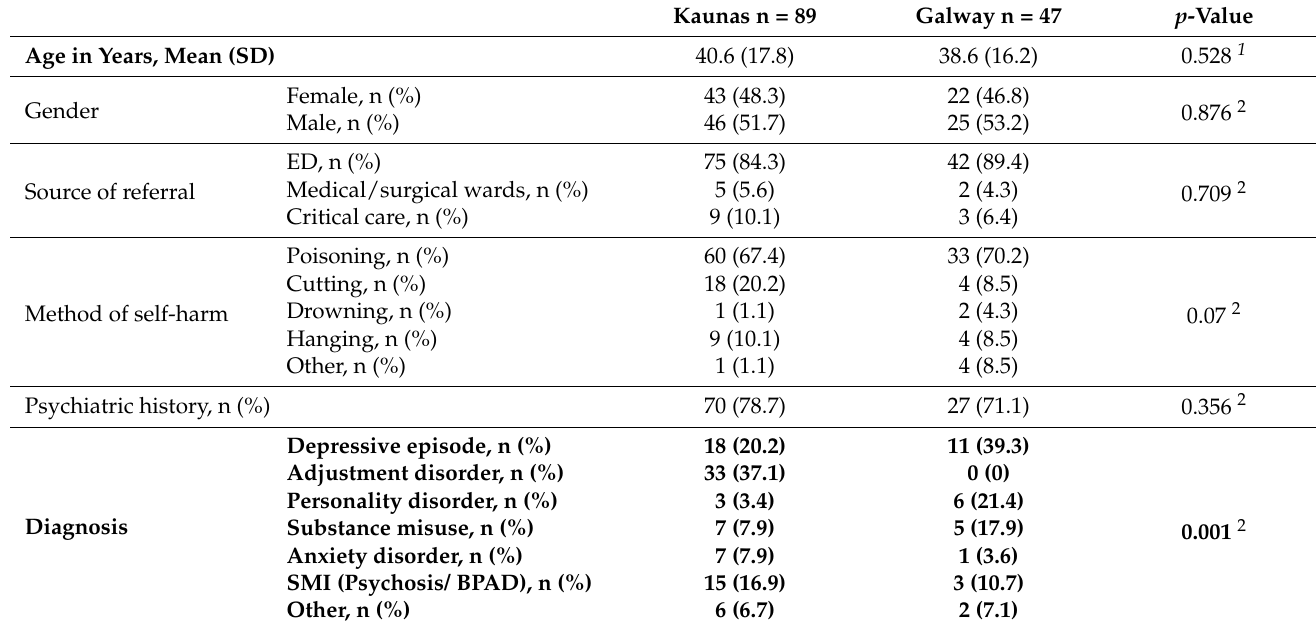
Table 3. Basic demographic and clinical details of patients presenting with self-harm who were admitted to a psychiatric unit at the two